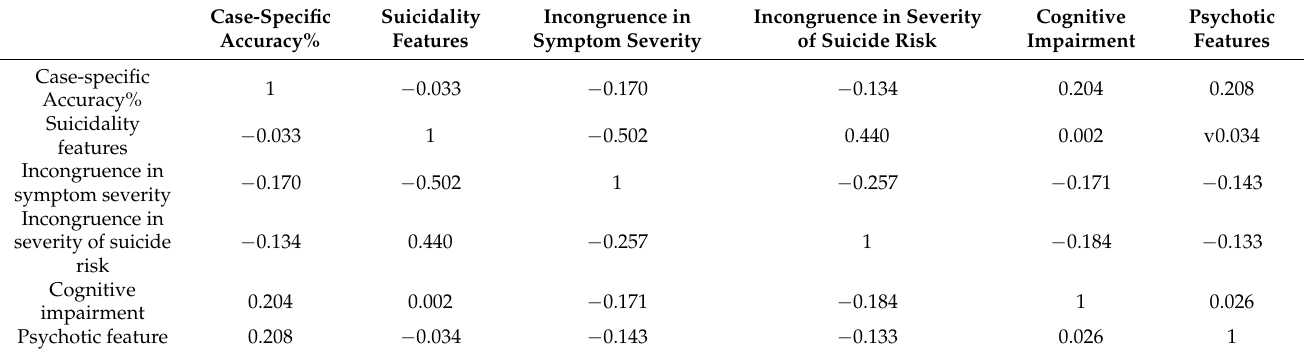
Table 5. Pearson’s correlation coefficients for associations between the clinical features and case- specific